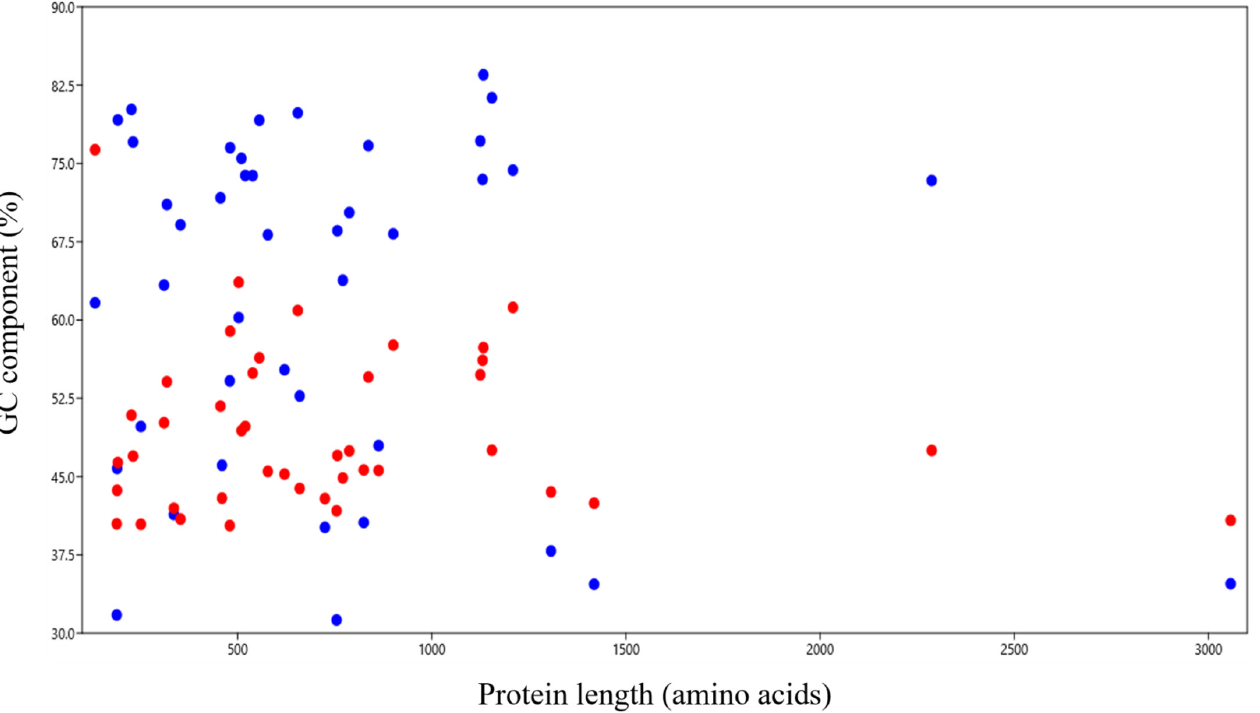
Figure 3. Relationship between protein length and %GC12 and %GC3 content of genes. Blue dots indicate %GC3 and red dots indicate %GC12.